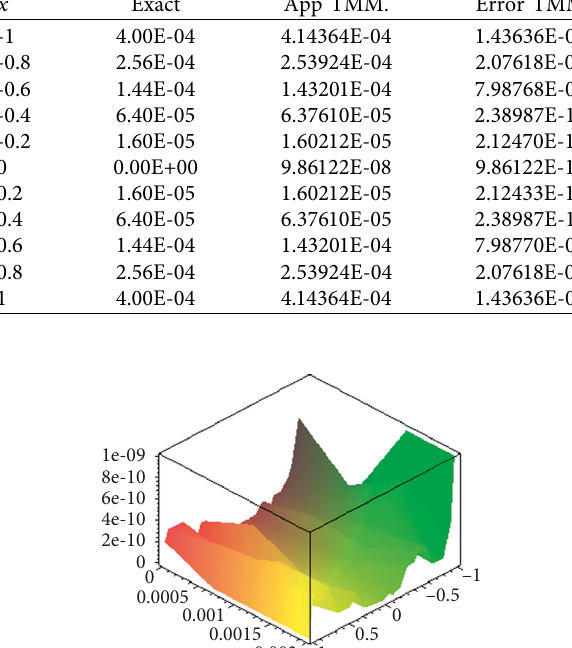
1 , T 0 . 3 (cid:27) (cid:27)